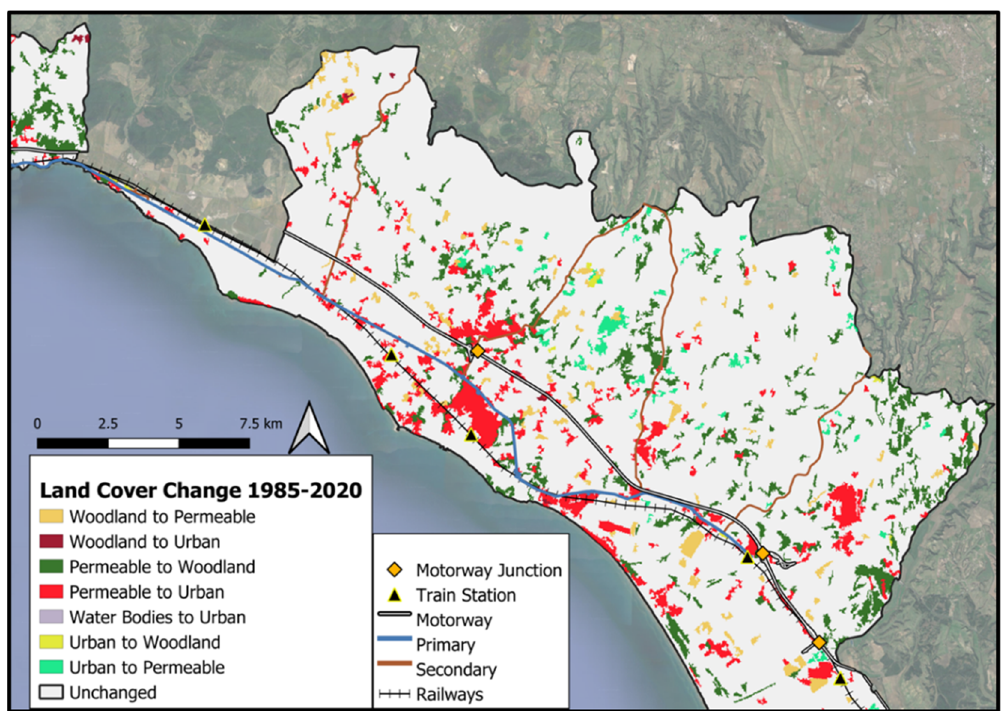
Figure 10. Variation and dynamics of LC within the Ladispoli and Cerveteri municipalities for the total time span (1985 ÷ 2020), sieved image at a threshold of 10 pixels, 4-bit connectivity.